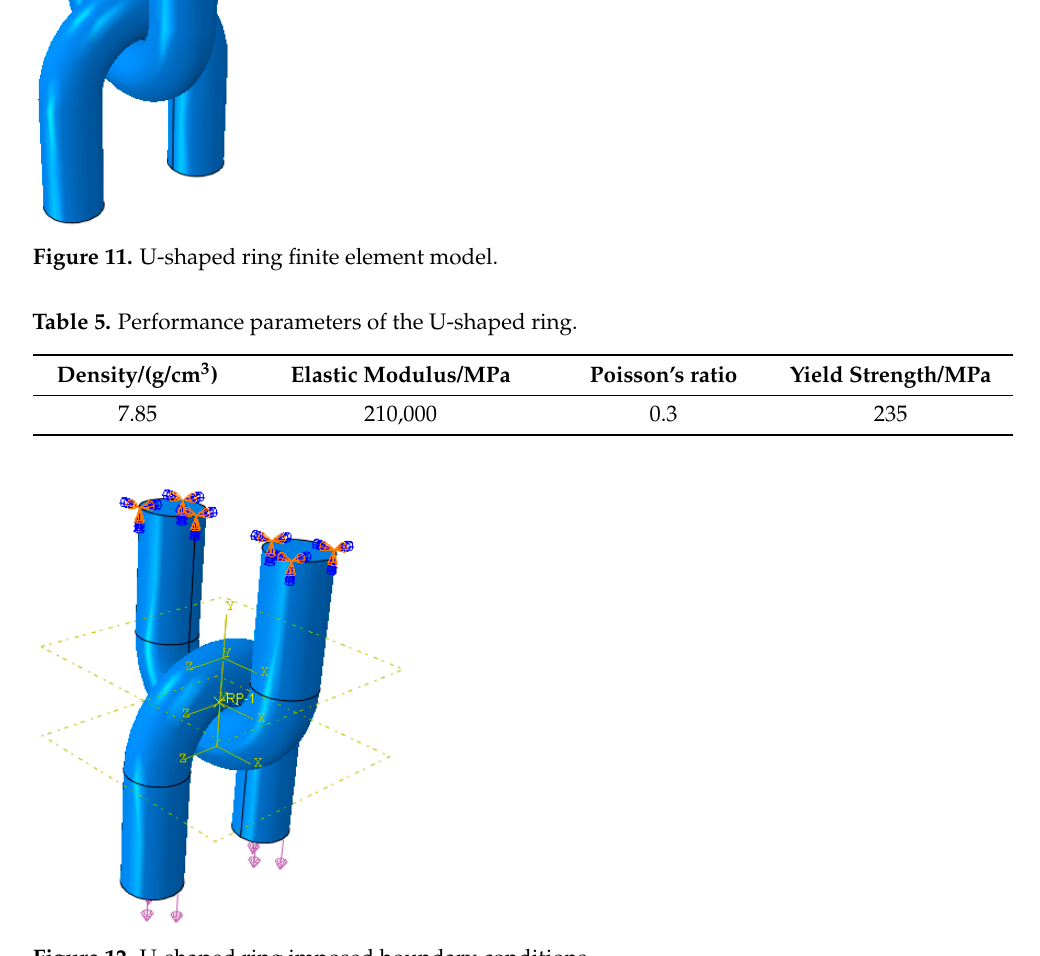
Figure 12. U-shaped ring imposed boundary conditions.